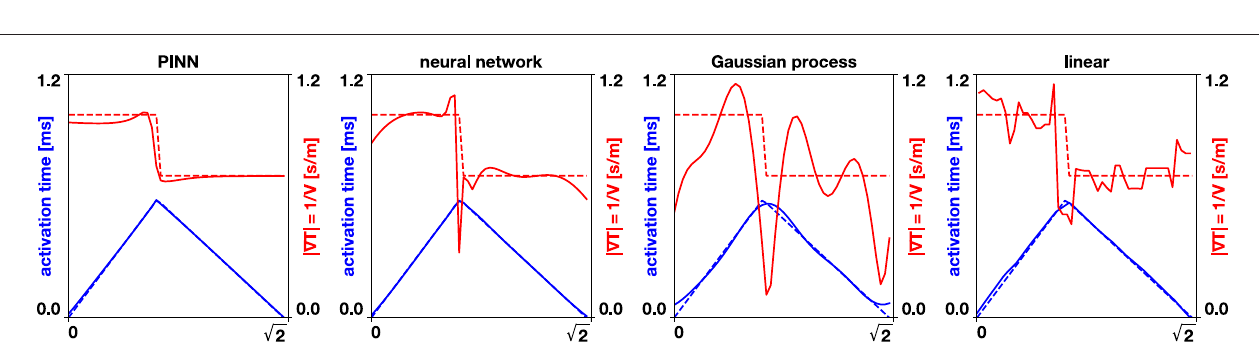
FIGURE 2 | Benchmark problem activation times and conduction velocities. The top row shows the activation times, the bottom row the conduction velocity. The columns display the exact solution and the results of the physics-informed neural network (PINN), a neural network without physics, the Gaussian process regression, and the linear interpolation. The black circles indicate the sampling locations.